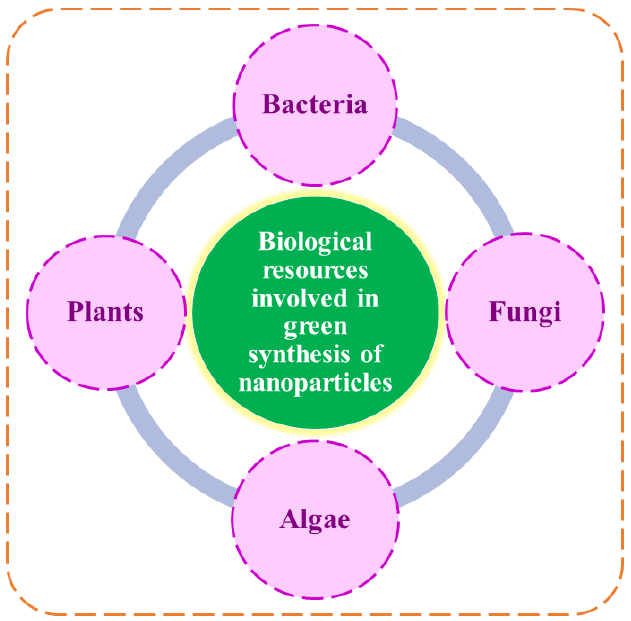
Figure 1. Various biological resources used for nanoparticle synthesis via green approach.